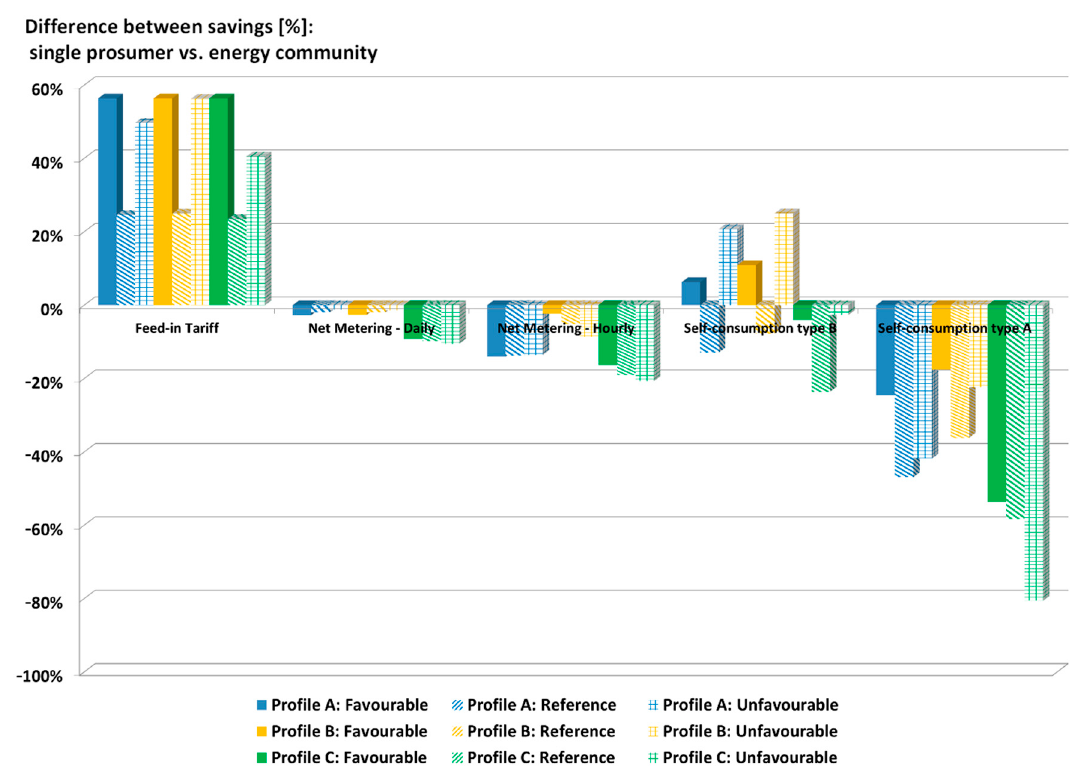
Figure 14. Comparative analysis of the energy economic results. Energy assets with ESS. Source: self-elaboration.